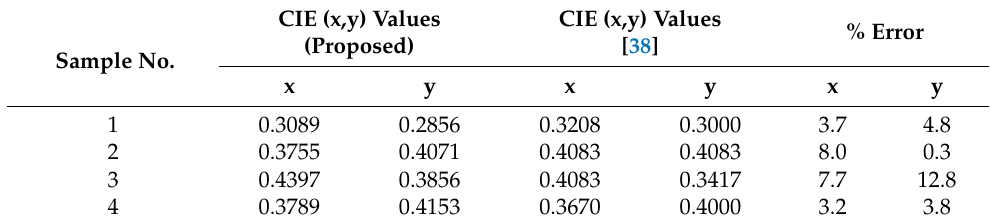
Table 3. Color error